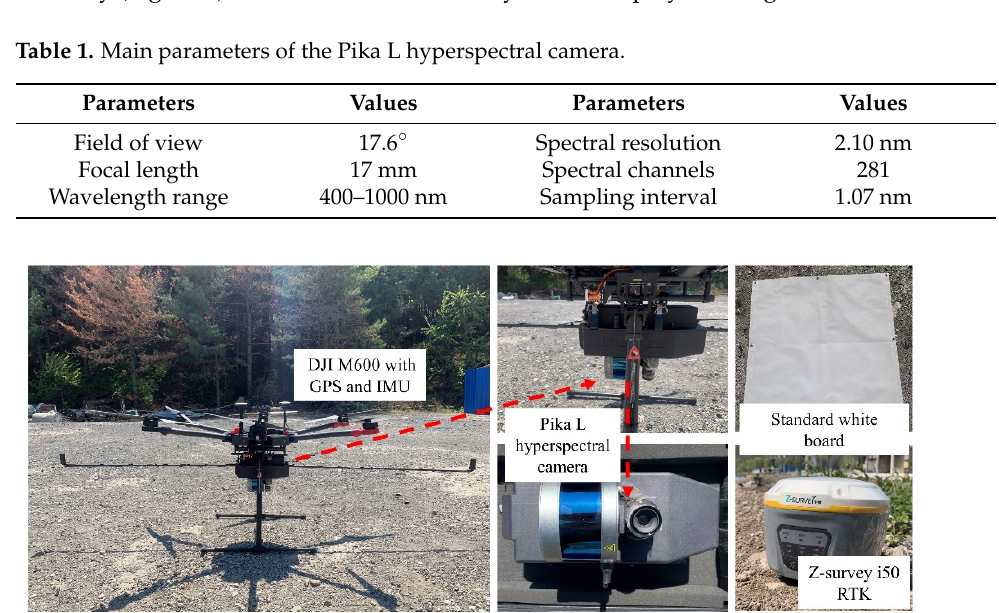
Figure 7. The UAV-based hyperspectral and LiDAR system.